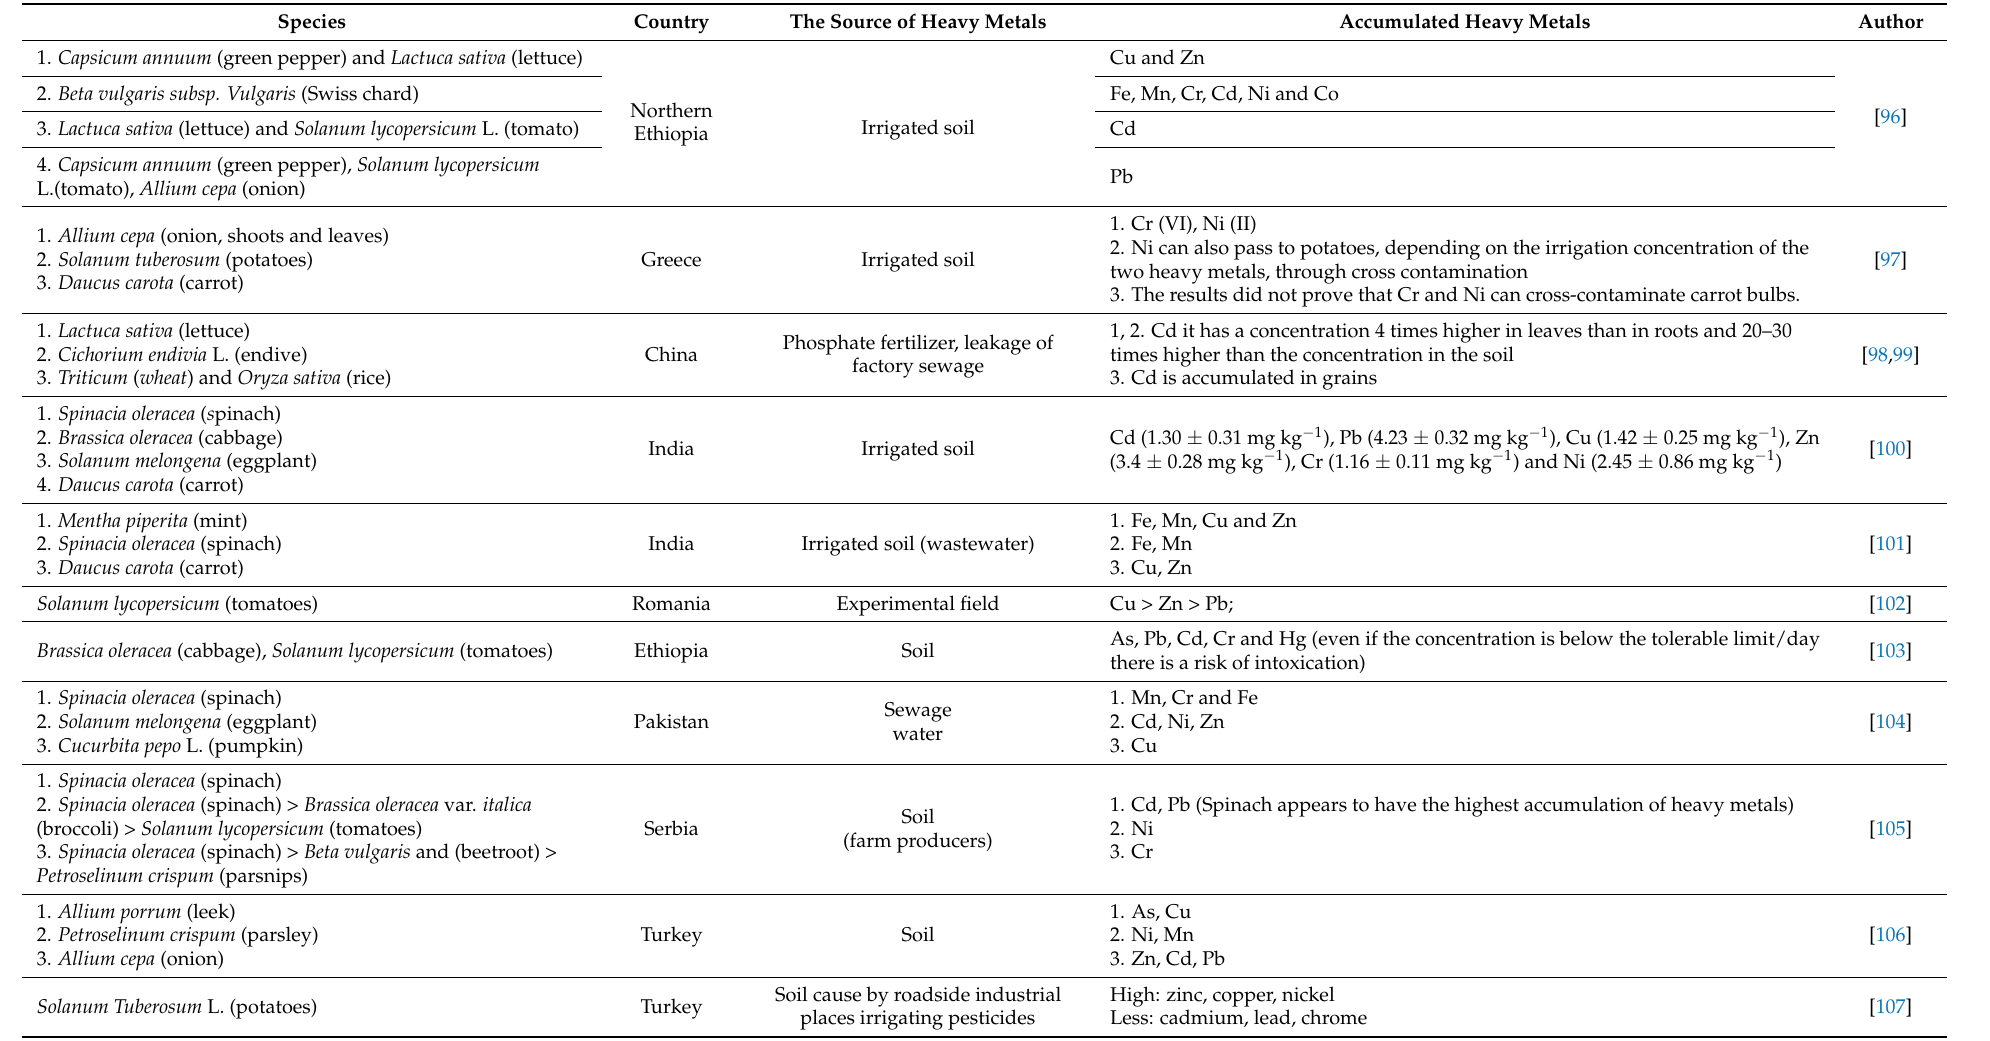
Table 1. Main sources of heavy metals and accumulation in products of vegetable